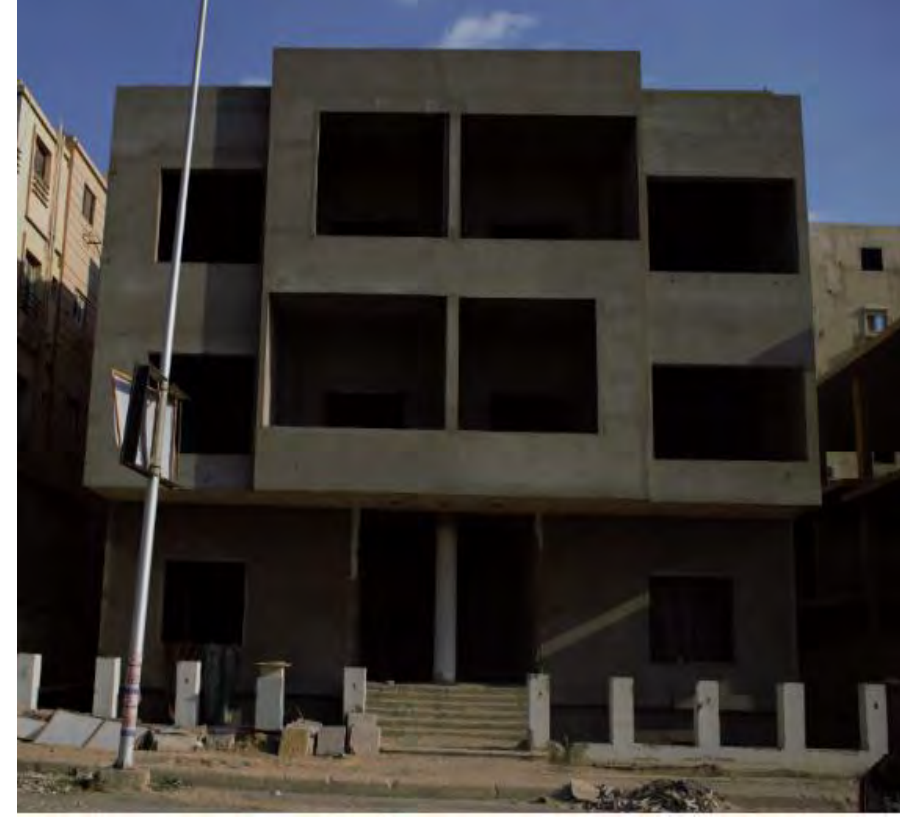
Fig 33: Building facades before vertical garden.